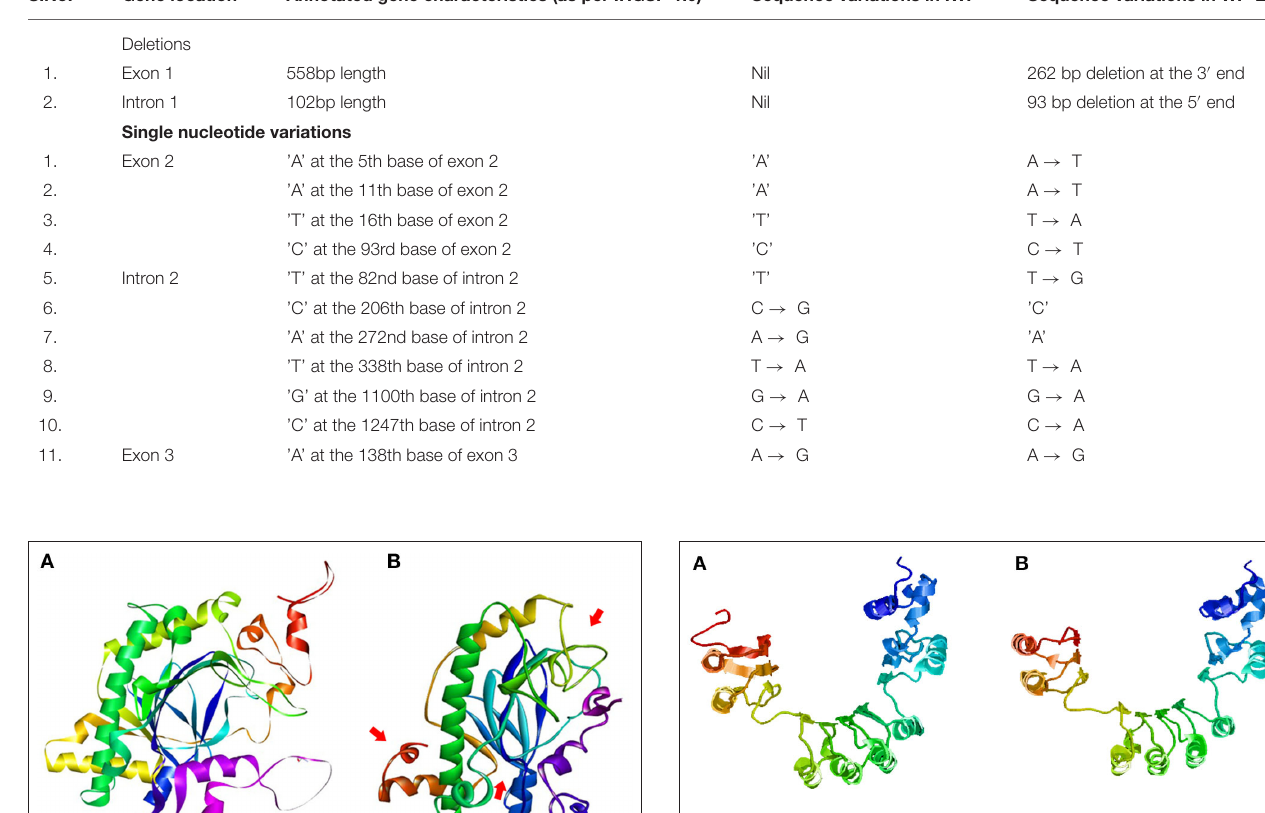
FIGURE 5 | Protein structure prediction for the OsFBX267 gene. (A) IWP; (B) WP-22-2—premature terminations and single nucleotide variations have caused structural changes in the